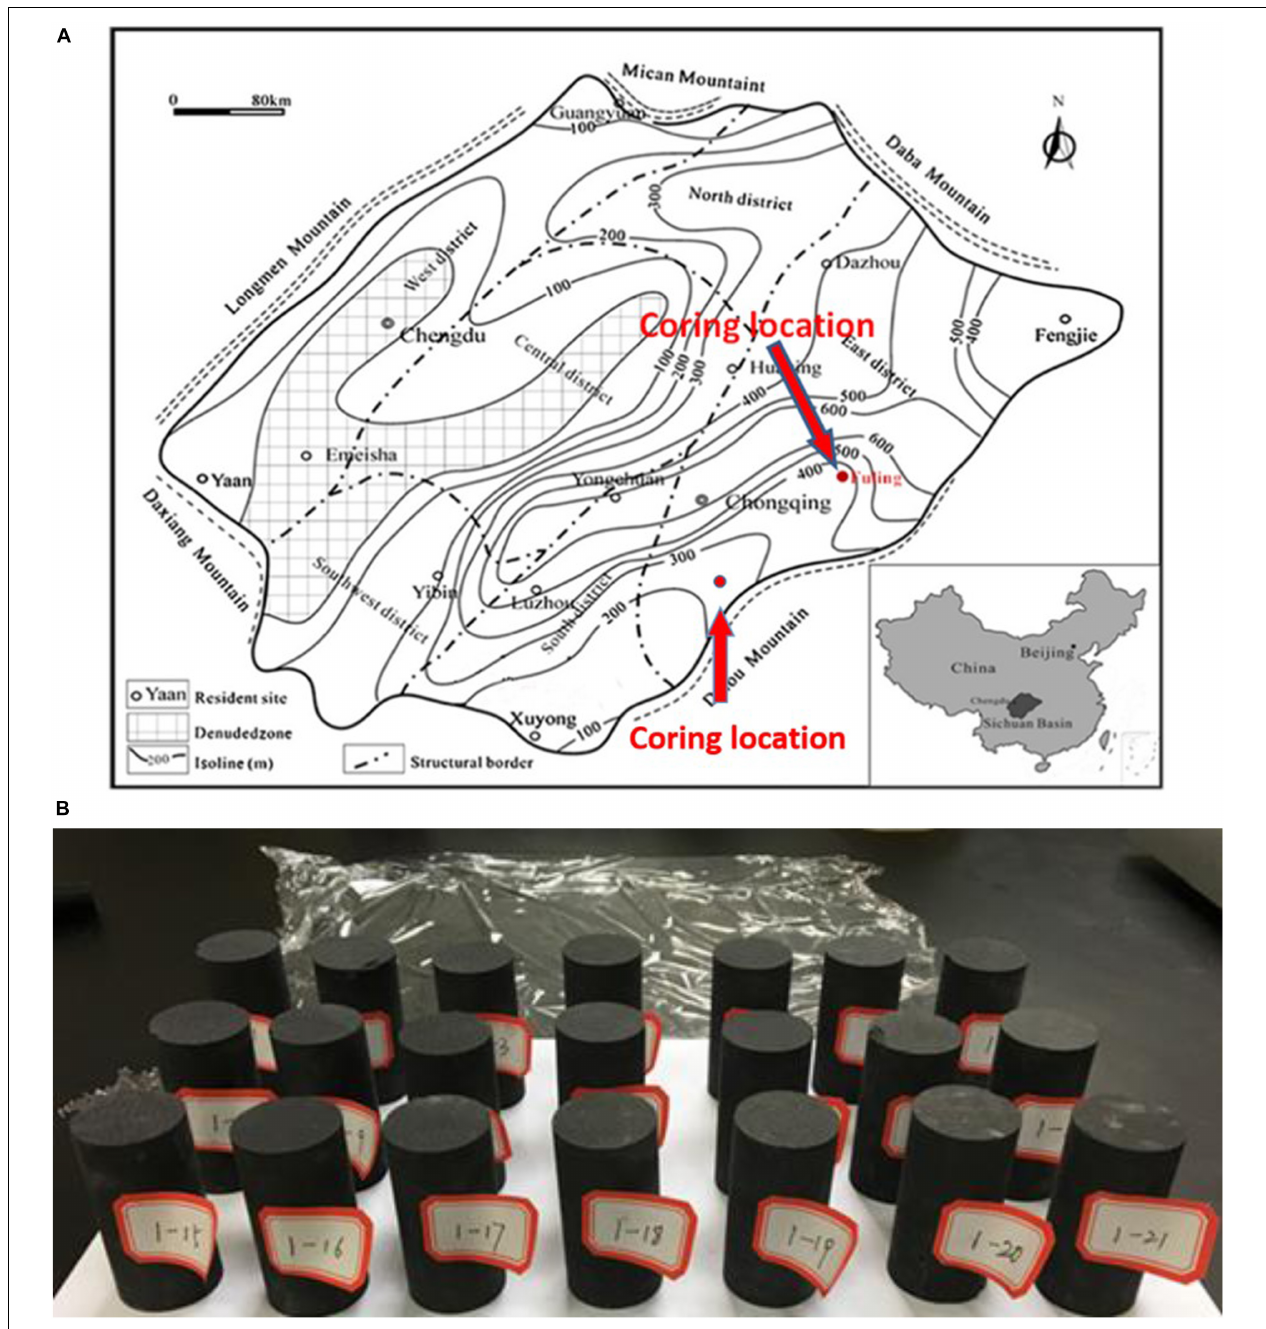
FIGURE 1 | (A) Location (insert) and topographic maps showing the shale drilling site. (B) Shale specimens before they were broken.